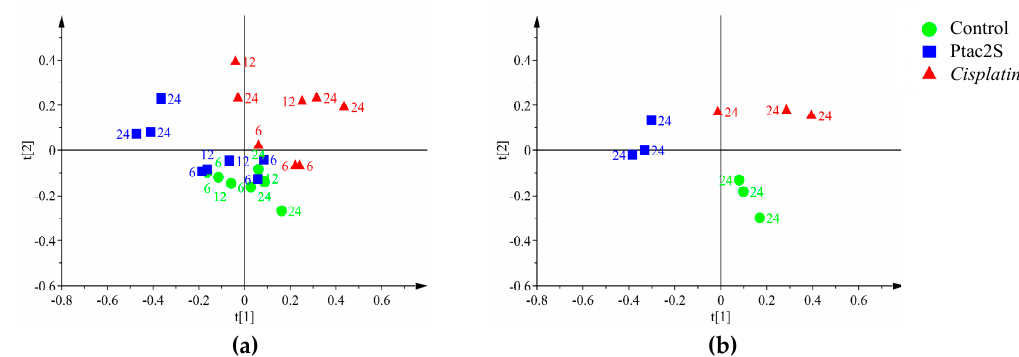
Figure 7. PCA score scatter plots of the 600 MHz 1 H-ZG-NMR spectra (Pareto scaled) obtained from lipophilic extracts of Ptac2S and cisplatin treated SKOV-3 cells in comparison with the untreated control samples. The indicated labels are referred to the culture times. ( a ) PCA t[1]/t[2] (four components give R 2 X = 0.905, Q 2 = 0.82). ( b ) PCA t[1]/t[2] (two components give R 2 X = 0.854, Q 2 = 0.771).